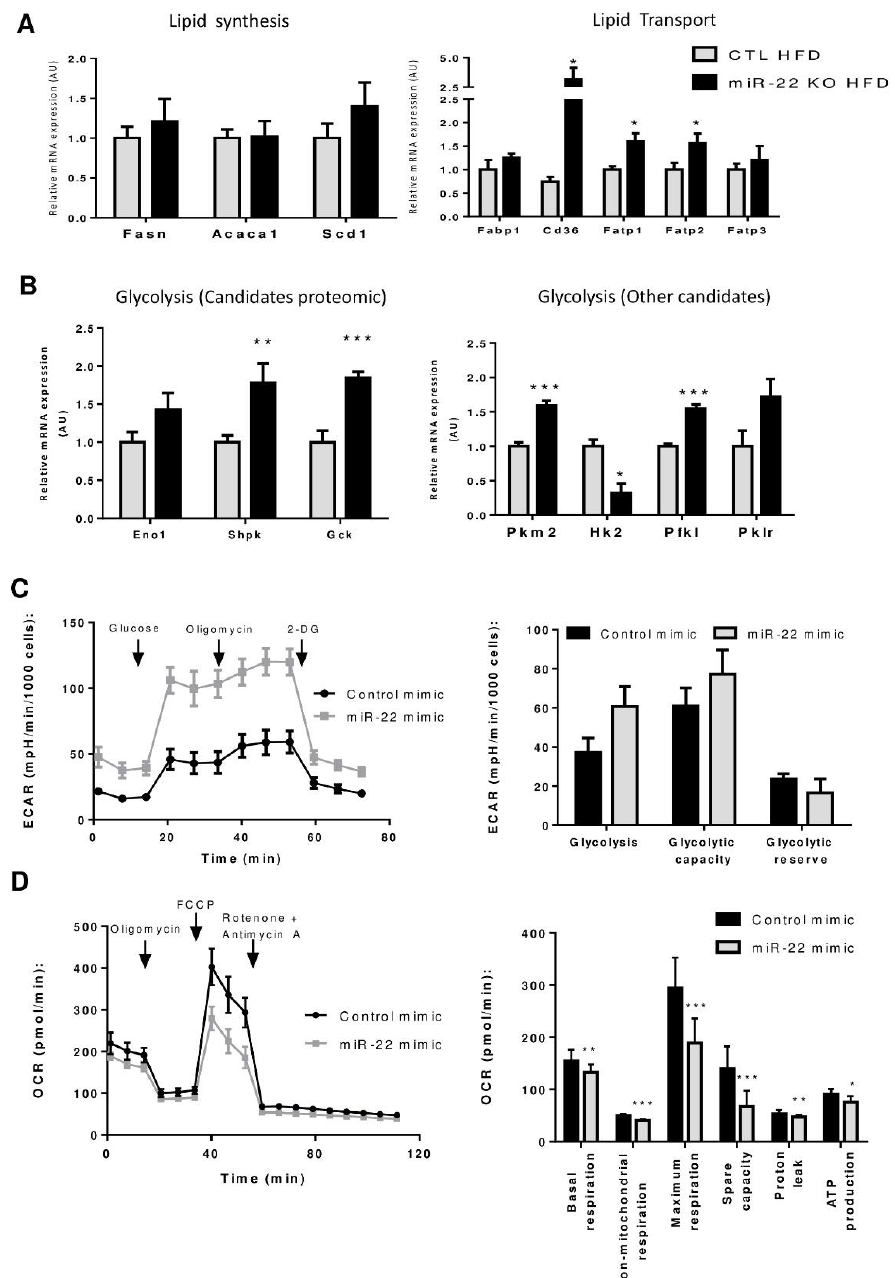
Figure 5. MiR-22-3p-dependent glucose/lipid metabolic activity. ( A ) RT-qPCR analyses of major effectors of lipid synthesis and transport in the livers of mice challenged 12 weeks with HFD. ( B ) RT-qPCR analyses of major effectors of glycolysis, predicted ( Eno1, Shpk, and Gck ) or not predicted as targets of miR-22-3p, in CTL and miR-22KO livers of mice challenged 12 weeks with HFD. For ( A ) and ( B ), data are mean ± SEM, n = 6–10 per group. * p < 0.05, ** p < 0.01, *** p < 0.001, compared with controls (Student t-test). ( C ) Seahorse glycolytic rate measurement (GlycoStress test) and ( D ) mitochondrial respiration rates (MitoStress test) in Huh7 human hepatic cancer cell line, transfected or not with 20 nM of miR-22-3p oligonucleotides for 48 h (n = 3). Data are represented as mean ± SEM. * p < 0.05, ** p < 0.01, *** p < 0.001, compared with controls (Student t-test).